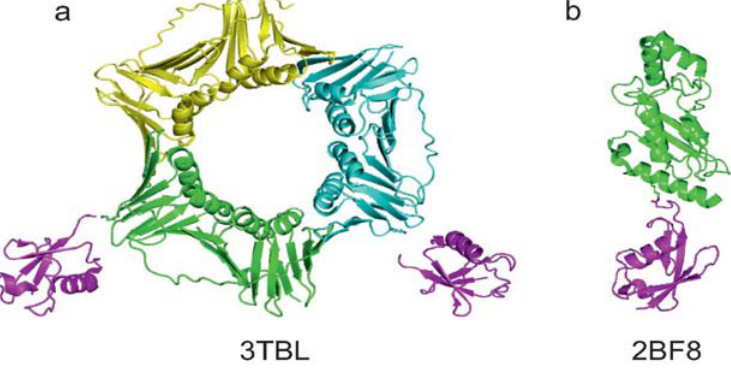
Figure 5. Summary of the currently available structures of ubiquitinated proteins. ( a ) Structure of mono-ubiquitinated PCNA (PDB code 3TBL). Note that the last GG moieties on the two Ub molecules do not appear in the PDB structure. K164 of two of the three monomers of the PCNA trimer are showed as sticks; ( b ) Structure of sumoylated E2-25K (PDB code 2BF8). K14 of E2-25K and G97 of SUMO are reported as sticks